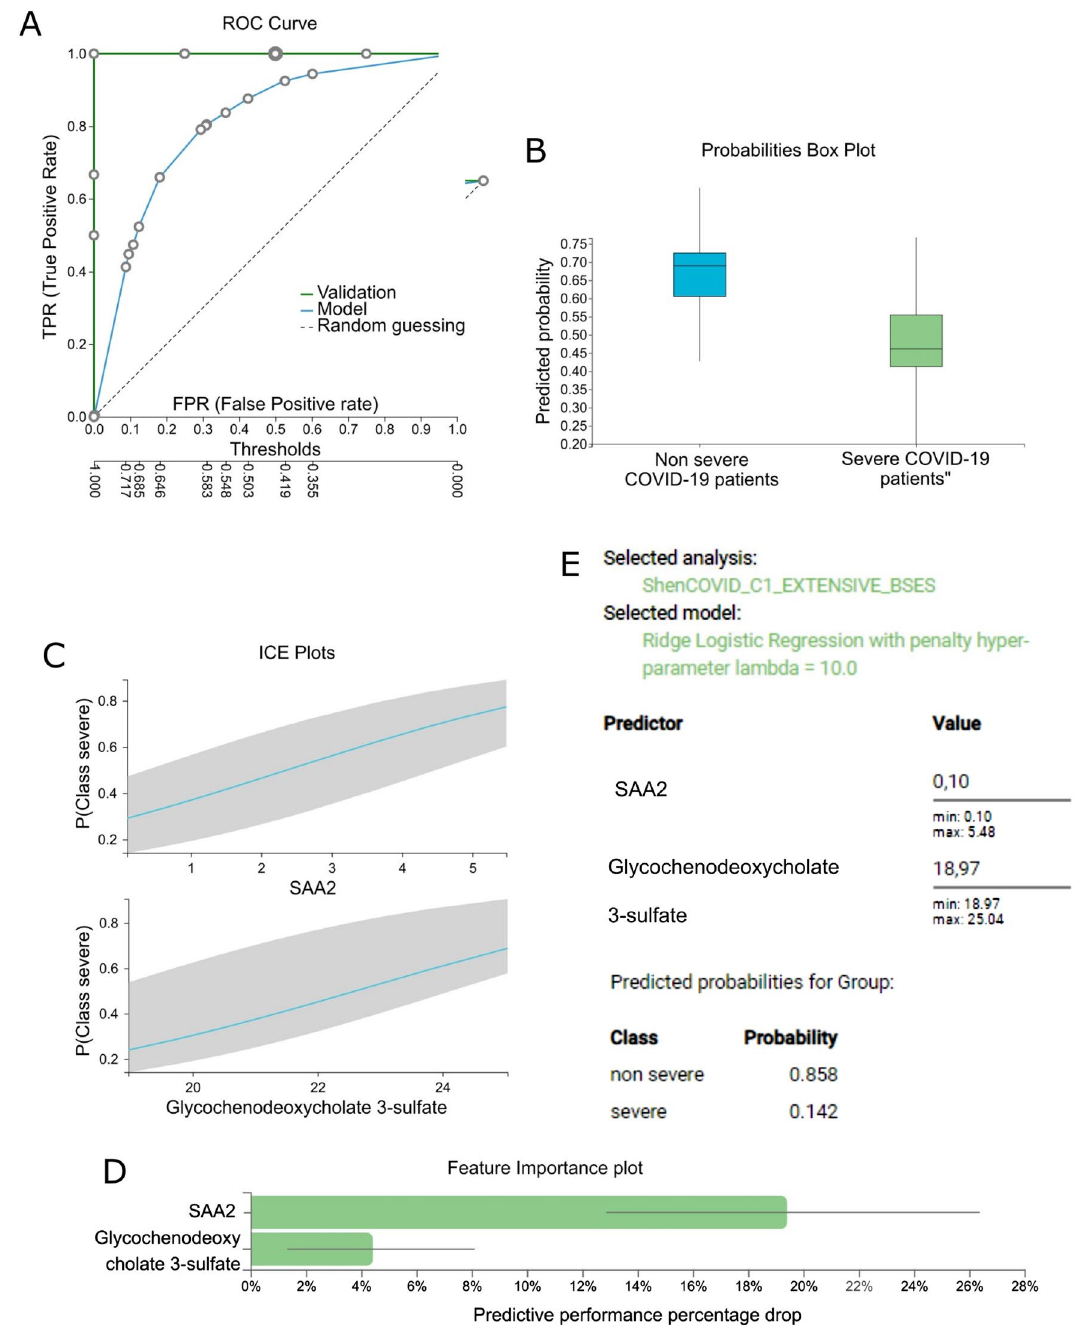
Figure 2. Predictive modeling results of JADBio using aggressive feature selection on the training and validation cohort data of Principal case (Shen et al.). ( A ) ROC plot of the model whose signature consists of SAA2 and glycochenodeoxycholate 3-sulfate showing both the training (blue) and validation (green) ROC curves. ( B ) Box plots of out-of-sample predictions on the training data (i.e., probabilities predicted when the given sample was in the test sets during cross-validation). ( C ) ICE plots of the selected features indicating the average probability predicted for the severe patients’ class given the value of the markers. ( D ) Feature importance for SAA2 and glycochenodeoxycholate 3-sulfate defined as the percentage drop in predictive performance when the feature is removed from the model. The grey lines indicate the 95% confidence intervals. ( E ) JADBio’s interface allows to predict the outcome for single samples, mimicking the application of the predictive model in a clinical setting. Here the (SAA2 and glycochenodeoxycholate 3-sulfate) model is applied on a fictitious patient resulting in predicting the rising of severe symptoms with 0.858